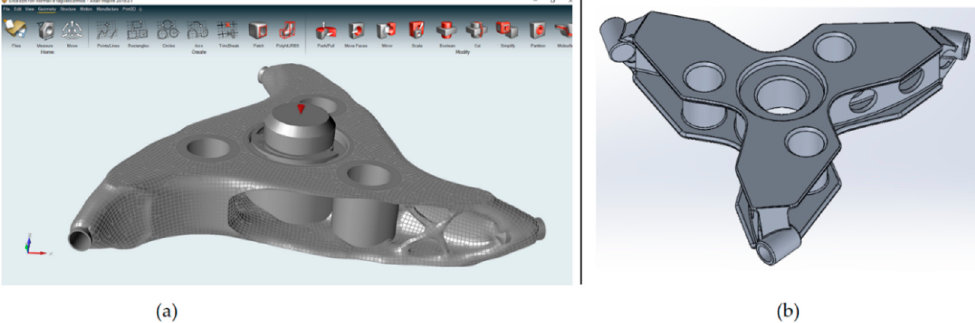
Figure 8. ( a ) One of the geometries obtained by TO in Altair Inspire 2019. ( b ) Redesigned PPC geometry modelled in Solidworks 2020.